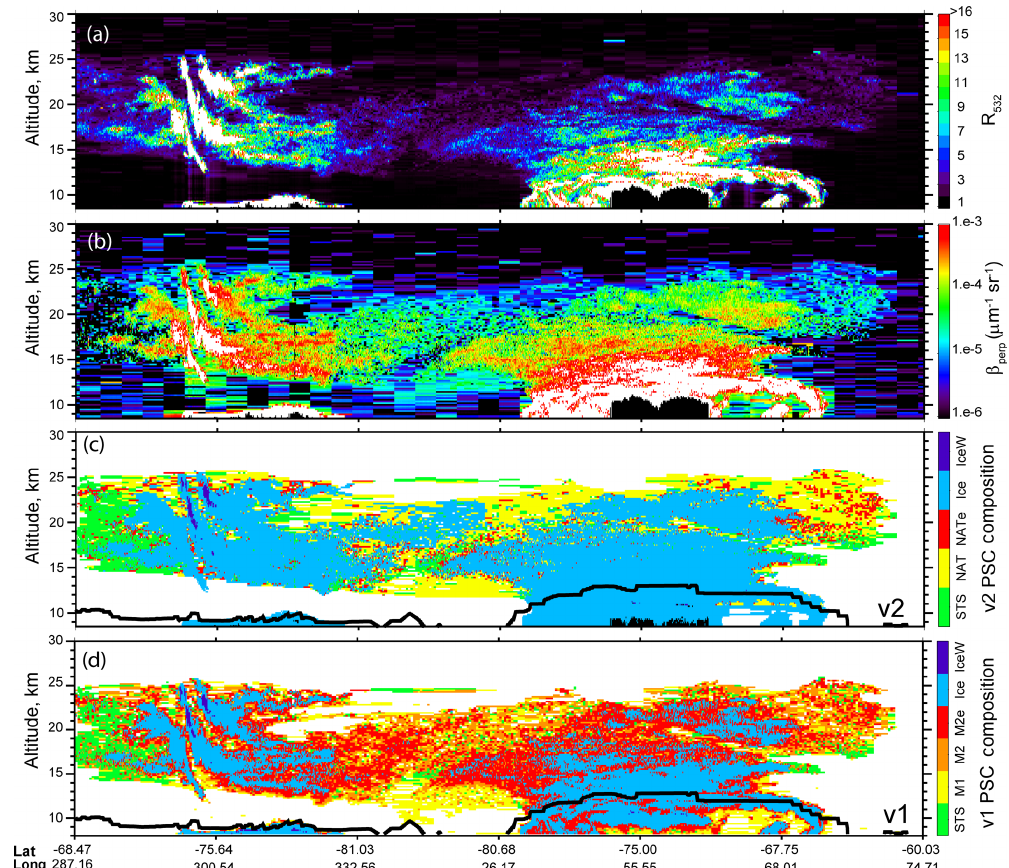
Figure 10. Curtains of CALIOP (a) R 532 , (b) β ⊥ , (c) v2 PSC composition, and (d) v1 PSC composition along the orbit track on 17 July 2008 highlighted in Fig. 1. The location of the MERRA-2 blended tropopause is shown in panels (c) and (d) by the solid black line.